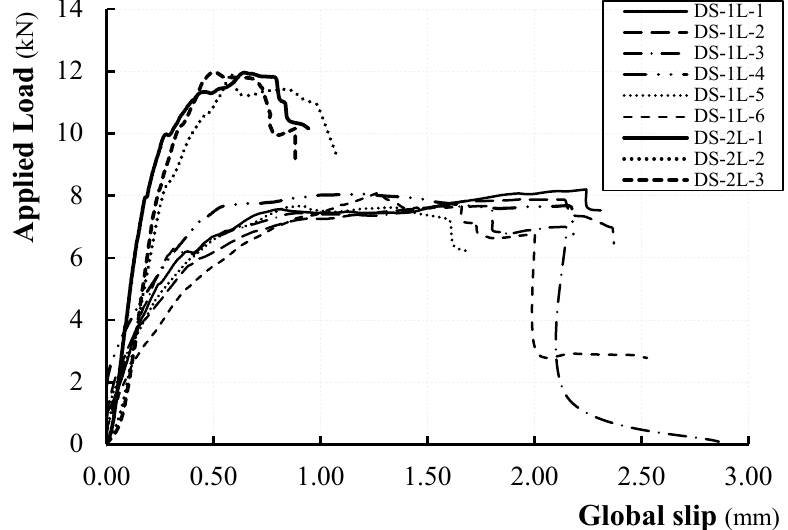
Figure 6. Load–global slip curves.